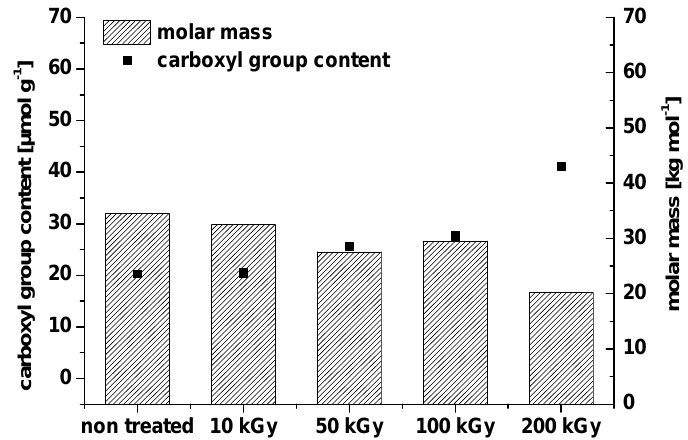
Figure 5. Weight average molar mass and carboxyl group content of microcrystalline cellulose after treatment with different dosage of electron beam irradiation.